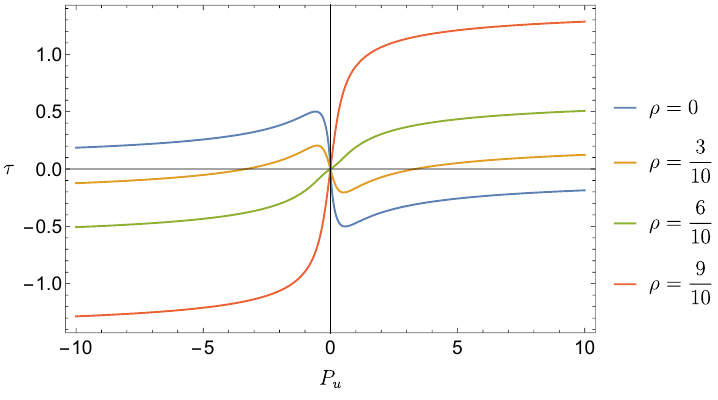
Figure 17 . The boundary time τ as a function of the conserved momentum P u as derived in (5.11). We consider three-dimensional de Sitter spacetime dS 2+1 and choose different stretched horizons at r = ρL in this plot. We note that it is not a monotonic function for smaller values of ρ , e.g., ρ = 0 and